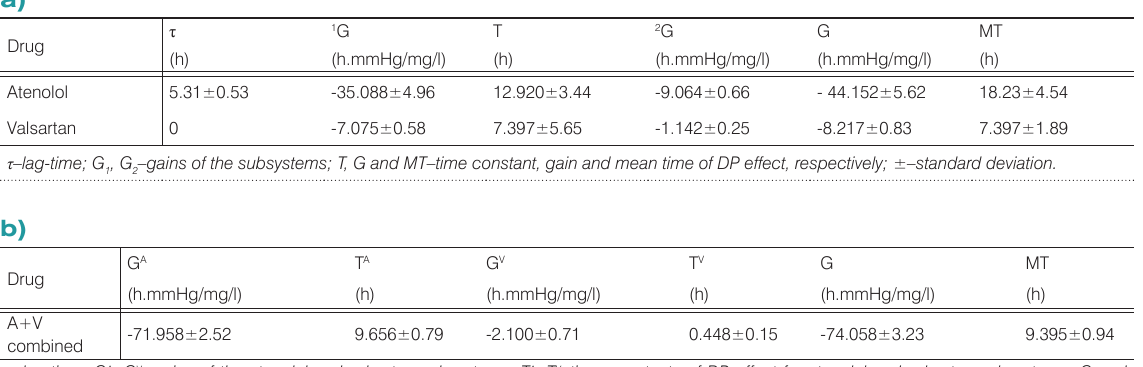
Table 5. The estimated model parameters of PK/PD system for DP after atenolol and valsartan administration separately (a) and in combination (b).